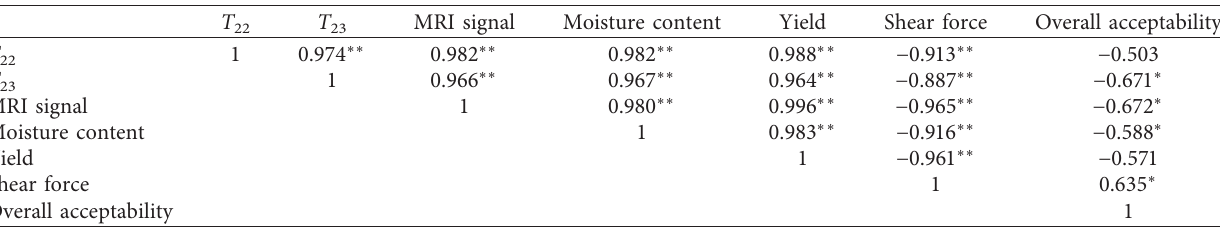
Table 5: Correlation coefficient among LM-NMR signal, moisture content, water activity, yield, shear force, and overall